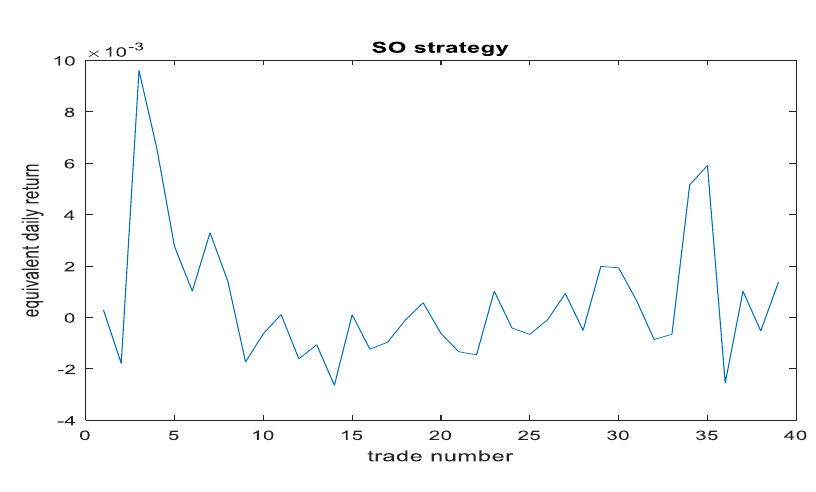
Figure 13. Equivalent daily return for each situation